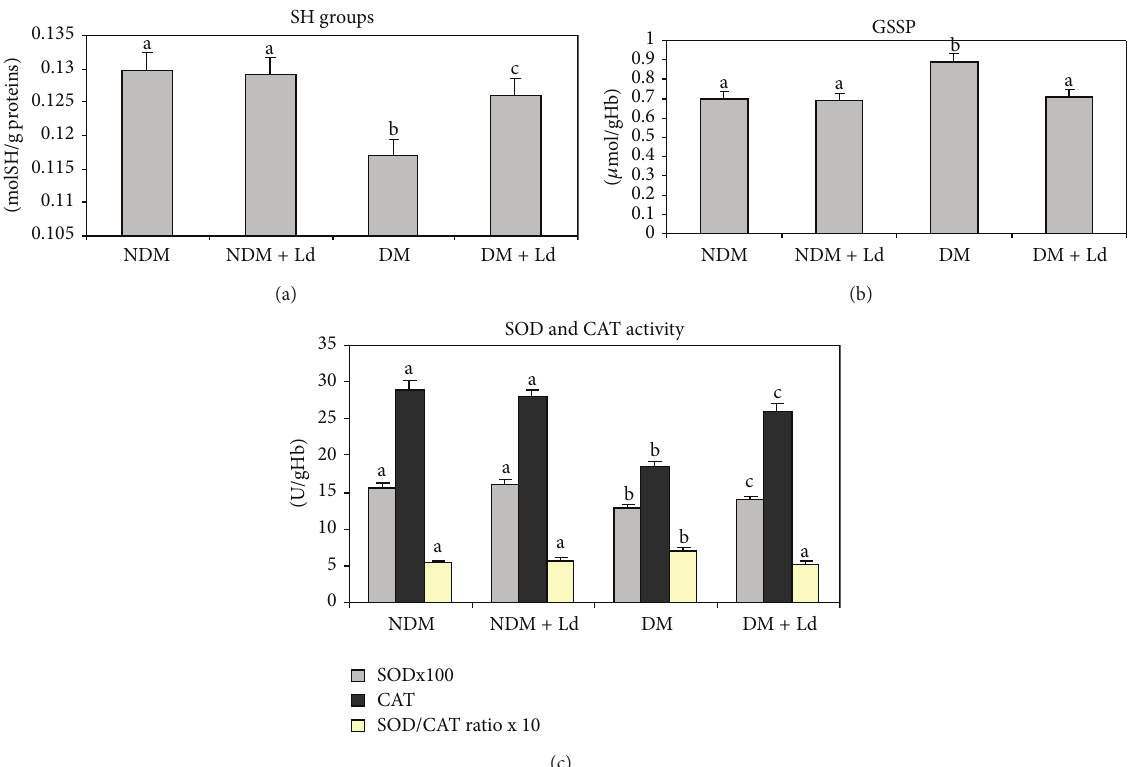
Figure 2: The effect of L. deterrimus extract administration on the content of free –SH (a), level of protein bound glutathione (GSSP) (b), and activities of antioxidative enzymes (c) in the circulation. NDM: control rats; NDM + Ld: control rats treated daily with L. deterrimus extract for four weeks; DM: STZ-induced diabetic rats; DM + Ld: STZ-induced diabetic rats treated with L. deterrimus extract for four weeks. The values are presented as the mean ± S.E.M.; values not sharing a common superscript letter differ significantly at 𝑃 < 0.05